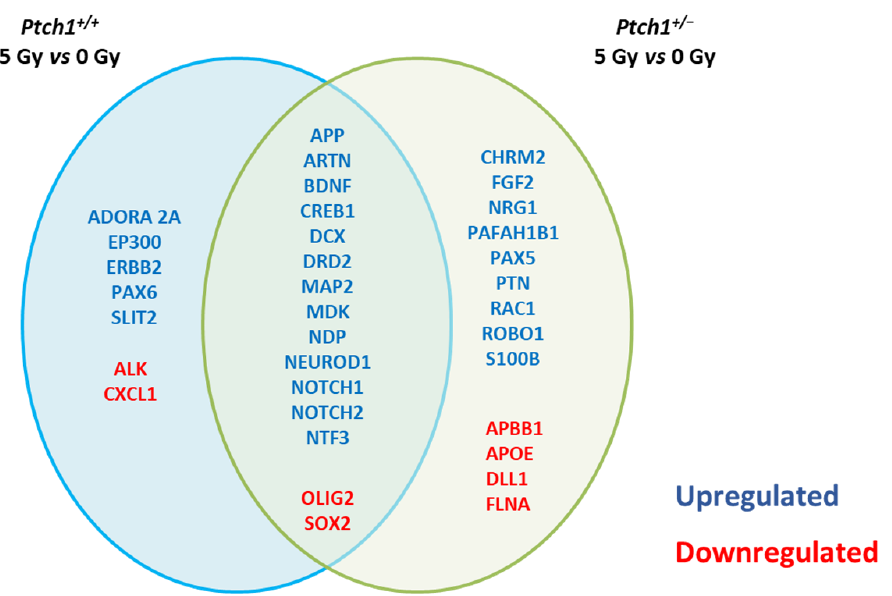
Figure 3. Long-term effect of irradiation with 5 Gy of X-rays at P10 on the expression of neurogenesis-related genes in the hippocampus of WT and Ptch1 +/ − mice at 8 months post-irradiation. Venn diagram of the exclusively deregulated and shared genes in the hippocampus of WT and Ptch1 +/ − mice irradiated vs. their respective unirradiated counterparts. A p -value ≤ 0.05 and a fold-regulation > 2 was defined as upregulation (blue); a p -value ≤ 0.05 and fold-regulation of <2 as downregulation (red).